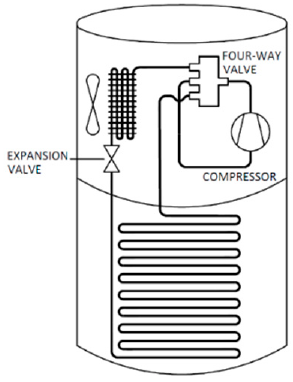
Figure 6. The schematic of the air-to-water heat pump as a DHW system. The effectiveness of ASHPs decreases as the ambient temperature drops in cold conditions. This is because less heat energy can be absorbed by the evaporator from the ambient air when the ambient temperature is low in winter [35]. In addition, frost formation is another major concern in selecting an ASHP. During the heating season, when the surface temperature of the evaporator coil is below 0 ◦ C, frost forms regularly. Frosting on the evaporator coil obstructs airflow and functions as a heat barrier, leading to a significant reduction in system performance [36]. Furthermore, frost can cause the liquid refrigerant to flood back into the compressor, causing space heating to fail. To achieve a better system performance, many studies have focused on the defrost mode of ASHPs. Main strategies include: (1) using an external heat source to heat the evaporator coil, (2) reversing the refrigeration cycle by using the four-way valve, or (3) adding the Dual Hot-Gas Bypass Defrosting to the outlet of the compressor [36,37]. Table 1 presents the summary of studies of